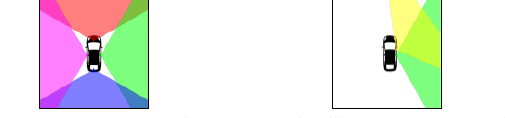
Figure 1 . Mounting configurations of different cameras. Left: mounting configuration used for Experiment I. Right: mounting configuration used for Experiment II.